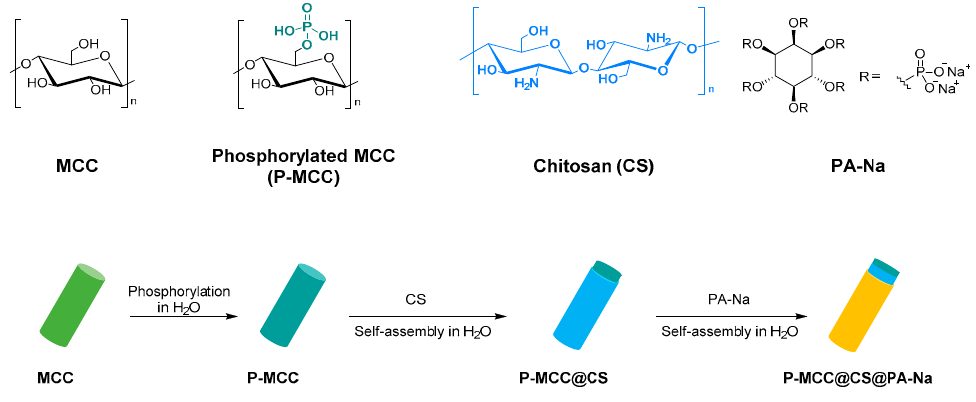
Figure 9. Synthesis P-MCC@CS@PA-Na.